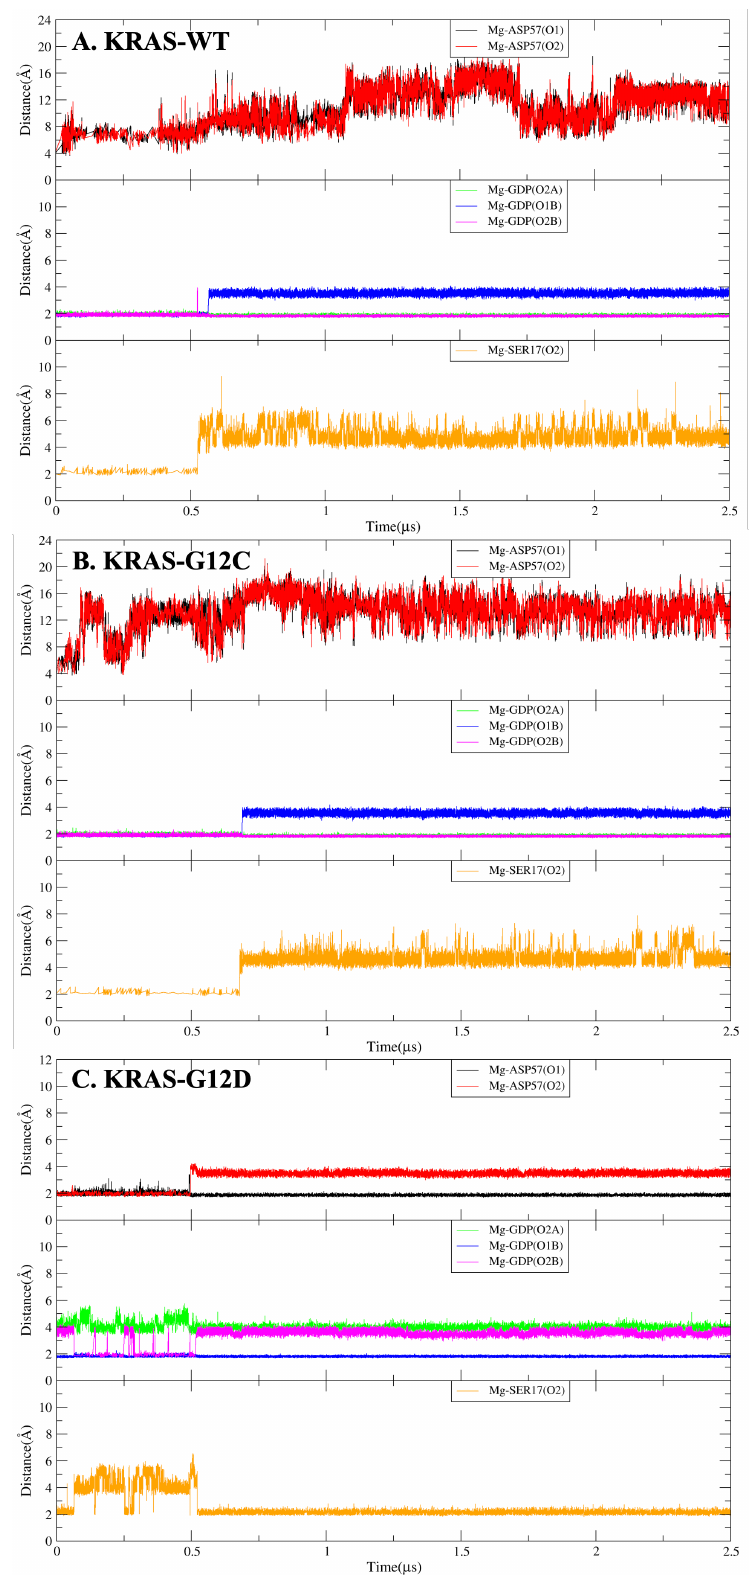
Figure A7. Coordination bonds analysis of Mg 2 + with related amino acid residues and GDP. ( A ) The Mg 2 + interaction with KRAS-WT-GDP; ( B ) the Mg 2 + interaction with KRAS-G12C-GDP; ( C ) the Mg 2 + interaction with